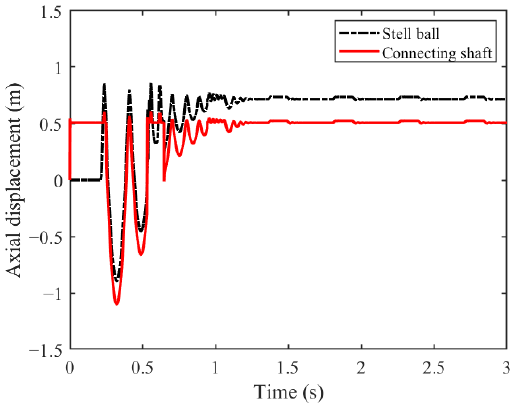
Figure 16. Axial displacement of steel ball and connecting shaft.